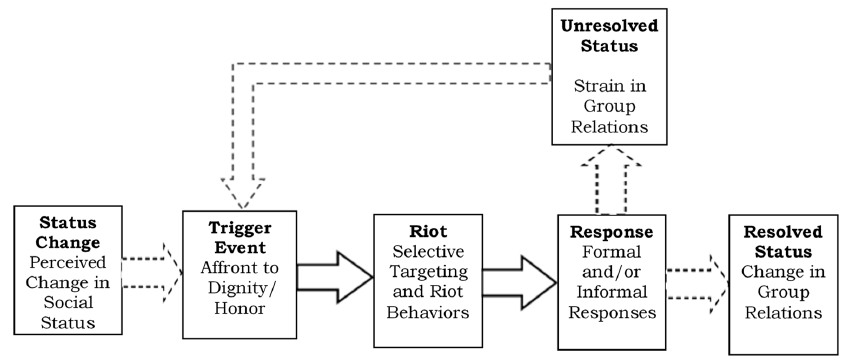
Figure 1. Status Change Riot Model.